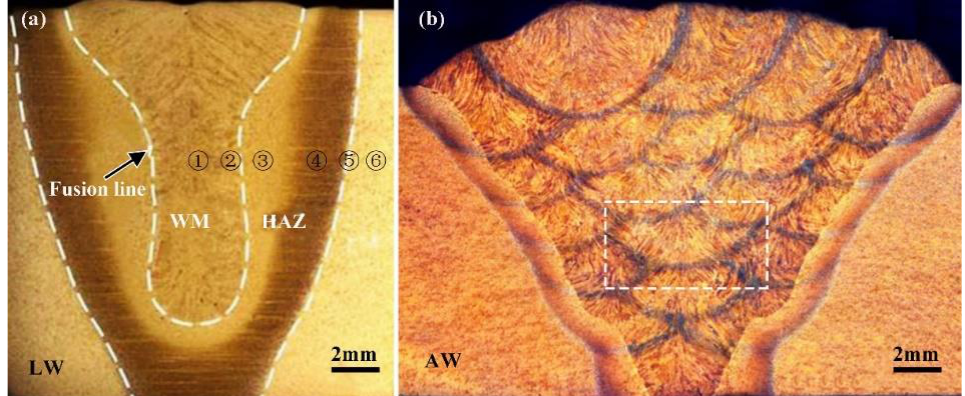
Figure 2. Optical morphology of joints ( a ) the LBW ( b ) the SMAW. ① Weld Metal